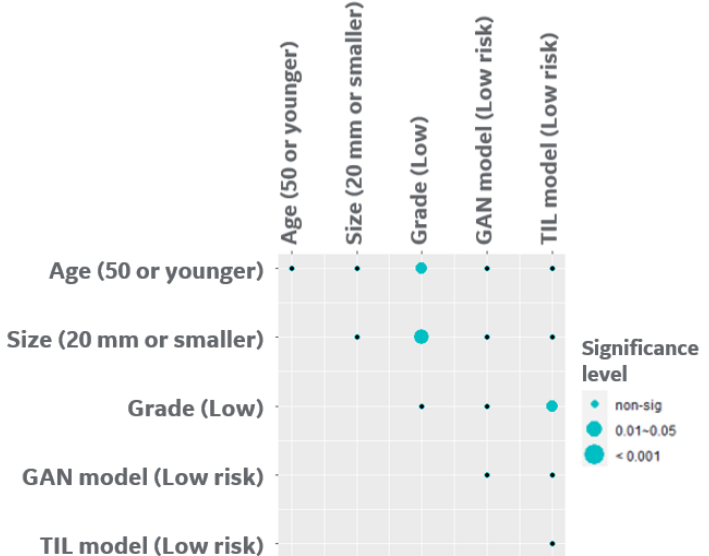
Figure 2. Correlation analysis of clinical factors along with risk prediction from each modality for the Singapore Cohort. The dependence of each pair was evaluated by Fishers exact test, and adjusted p (FDR) = 0.1 was applied to 10 pairs; p -value was adjusted using Benjamini–Hochberg method.